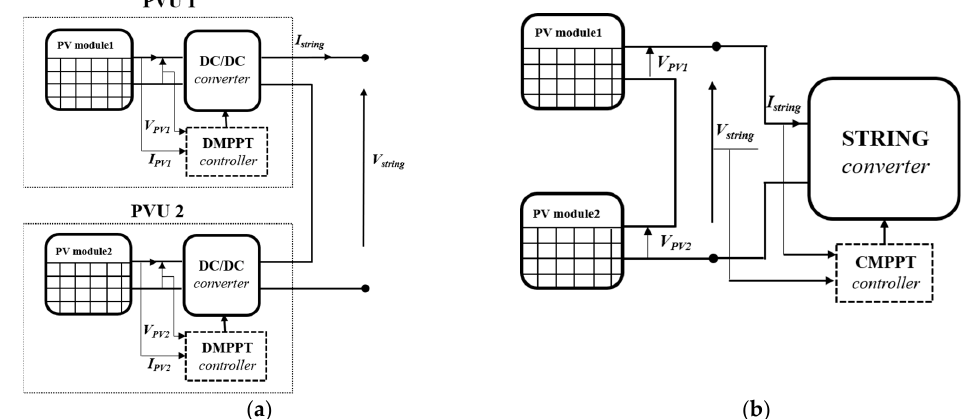
Figure 2. Systems under test: ( a ) DMPPT PV System; ( b ) Central Maximum Power Point Tracking (CMPPT) PV system.